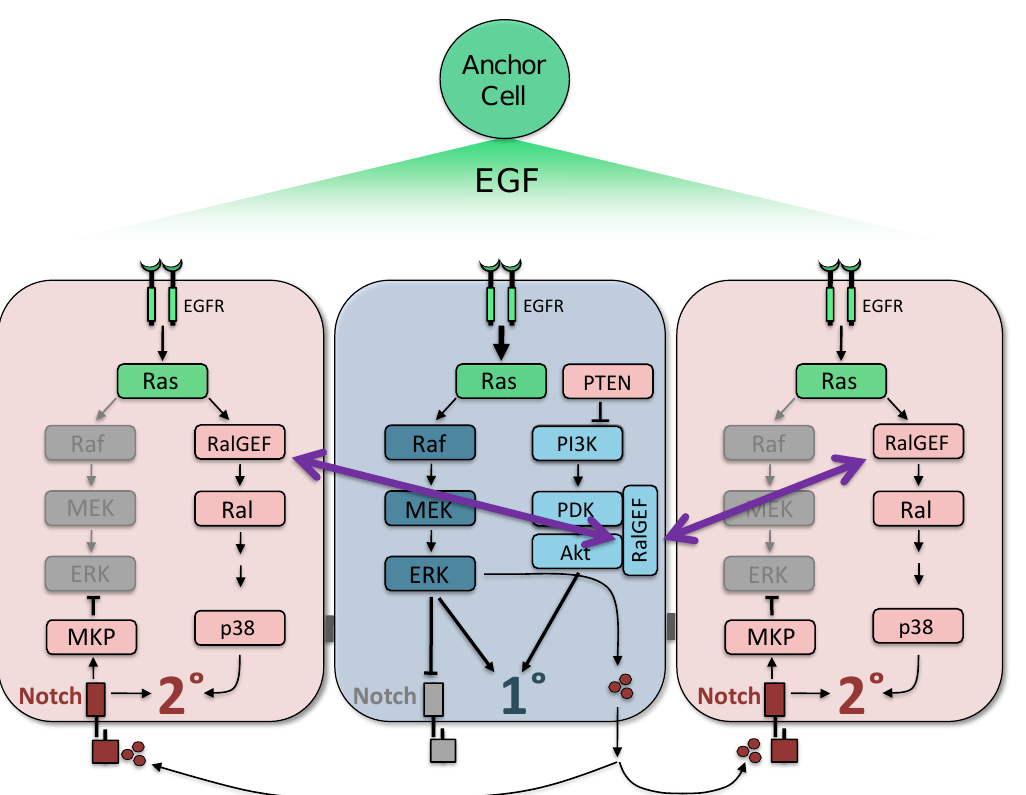
Figure 1. Models of C. elegans vulval precursor cells (VPCs) fate patterning and the dual function of RalGEF RGL-1 in modulatory signaling cascades. Equipotent VPCs are patterned by graded EGF